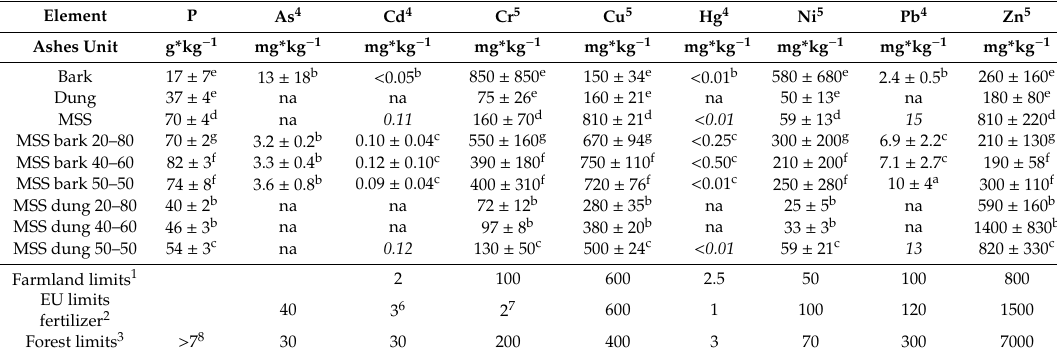
Table 3. Concentrations of selected elements in ashes from lab-scale experiments given as mean values with sample standard deviations (n = 2–9). Values given in italics are based on single data points. All concentrations are given on dry weight basis.